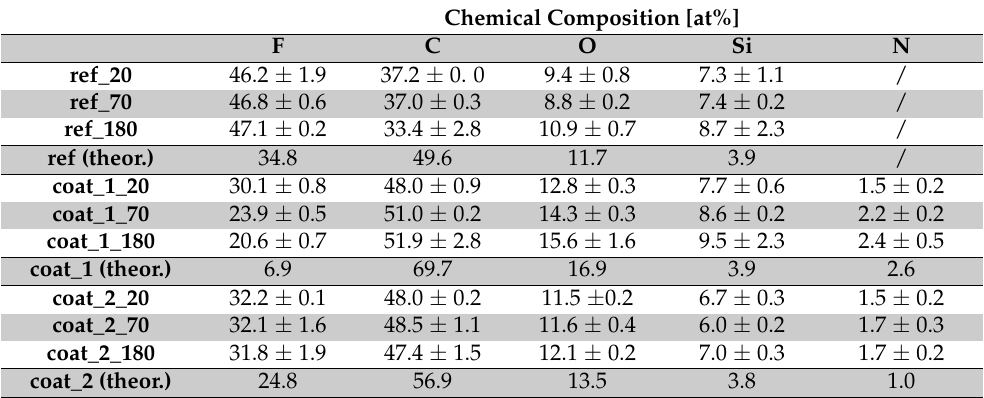
Table 2. Chemical composition of reference coatings and coatings containing NIPTES (all data refer to the surface composition in atom-% calculated from XPS data; hydrogen is